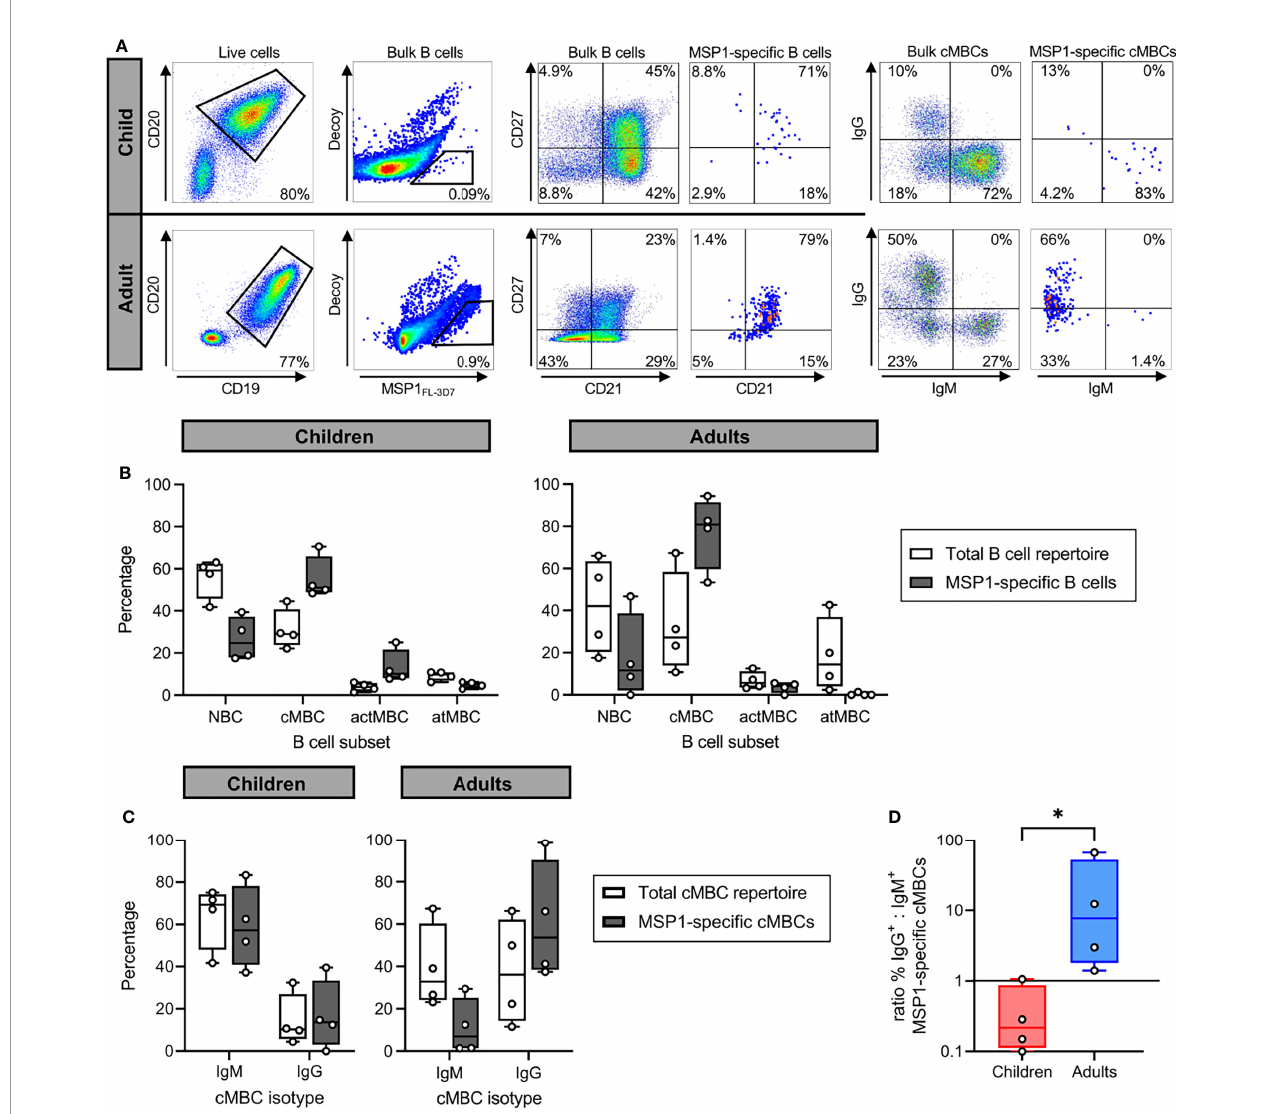
FIGURE 2 | The isotype of PfMSP1 FL-3D7 -speci fi c B cells in malaria-experienced children and adults. (A) Representative fl ow cytometry gating for the sorting and analysis of bulk B cells and PfMSP1 FL-3D7 -speci fi c B cells. B cells were fi rst gated as live CD19 + CD20 + cells, followed by sorting of PfMSP 1 + FL − 3 D 7 decoy − cells. The four major B cell subsets are de fi ned as follows: naïve B cells (NBC), CD21 + CD27 - ; classical memory B cells (cMBC), CD21 + CD27 + ; activated memory B cells (actMBC), CD21 - CD27 + ; and atypical memory B cells (atMBC), CD21 - CD27 - . Data are shown as pseudocolor plots, in which overlapping cells in the plots showing PfMSP1 FL-3D7 -speci fi c B cells and cMBCs are shown in orange and red. (B) Relative abundance of major B cell subsets among the total B cell repertoire and among PfMSP1 FL-3D7 -speci fi c B cells in partially immune children (n = 4) and immune adults (n = 4). (C) The percentage of IgM + and IgG + B cells among the total repertoire of cMBCs and among PfMSP1 FL-3D7 -speci fi c cMBCs in malaria-experienced children (n = 4) and adults (n = 4). In panels B and C, differences were not tested for statistical signi fi cance because the appropriate non-parametric test for paired data (Wilcoxon signed-rank test) does not return a P value lower than 0.13 when using groups of 4. (D) The ratio of the percentage of IgG + over IgM + PfMSP1 FL-3D7 -speci fi c cMBCs in malaria-experienced children and adults. A data point with value 0 was plotted at 0.1 for visualization purposes. The difference between groups was tested for statistical signi fi cance using a Mann Whitney test. *P <